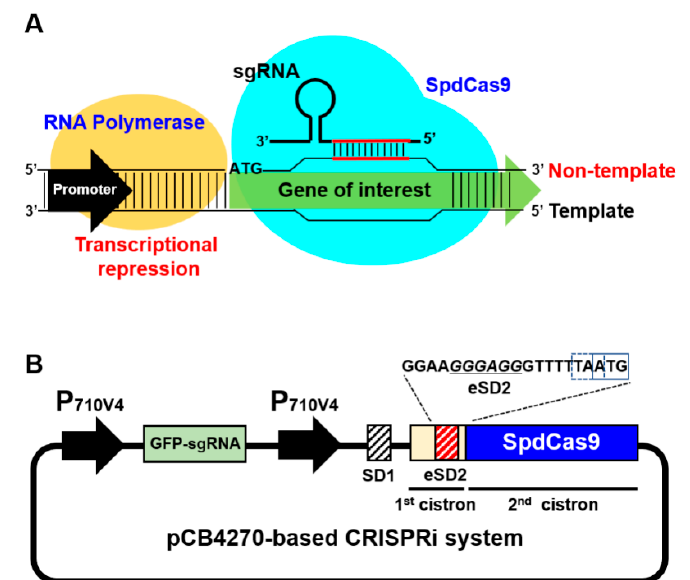
Figure 1. (A) Schematic of the CRISPRi system . (B) Schematic diagram of the plasmid pGFP–sgR–D1–Em constructed for the CRISPRi system for L. citreum. Dashed and solid boxes in the DNA sequences indicate the stop codon of the first cistron and start codon of second cistron (SpdCas9), respectively. The ability of the SpdCas9-mediated CRISPRi system (pGFP–sgR–D1–Em) to regulate the expression of the sfGFP gene was evaluated using L. citreum JW001, in which the sfGFP gene expression cassette was integrated into the ldhD locus of L. citreum CB2567. L. citreum JW001